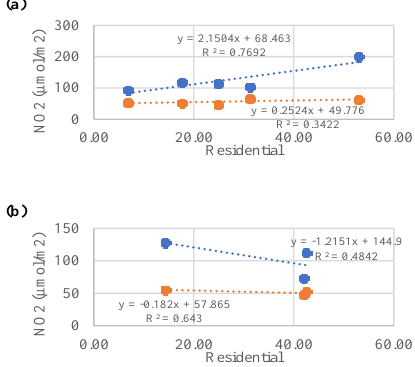
Figure 6. Influence of residential landuse on NO 2